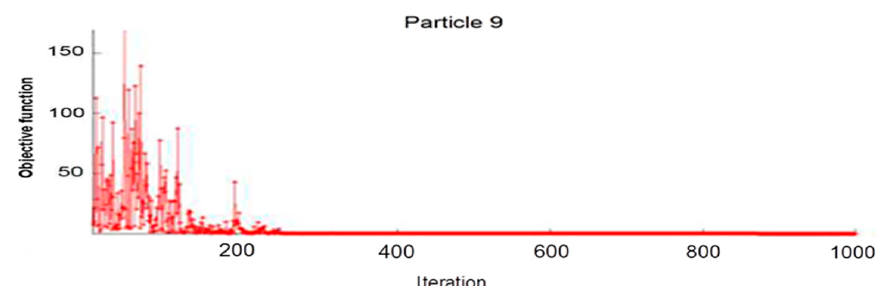
Figure 9. Evolution of the objective function according to particle 9.